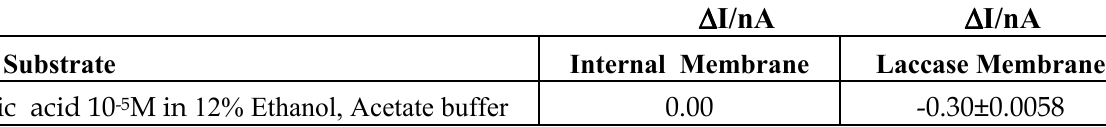
Table 2. Response of the electrode base system to caffeic acid in 12% ethanol, acetate